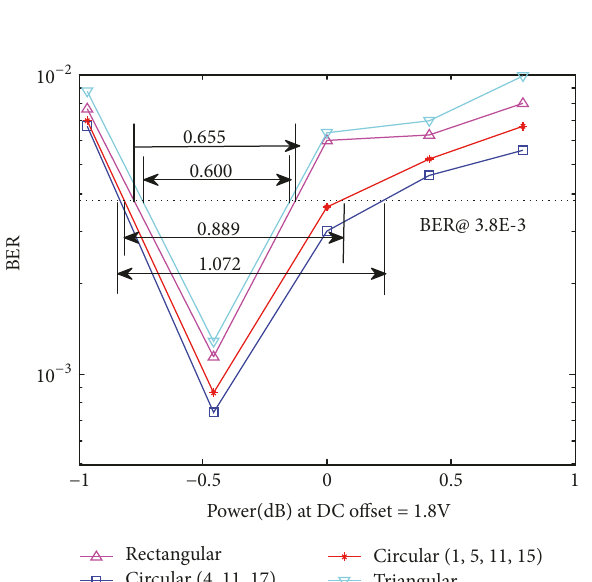
Figure 6: U-I curve of the LED.